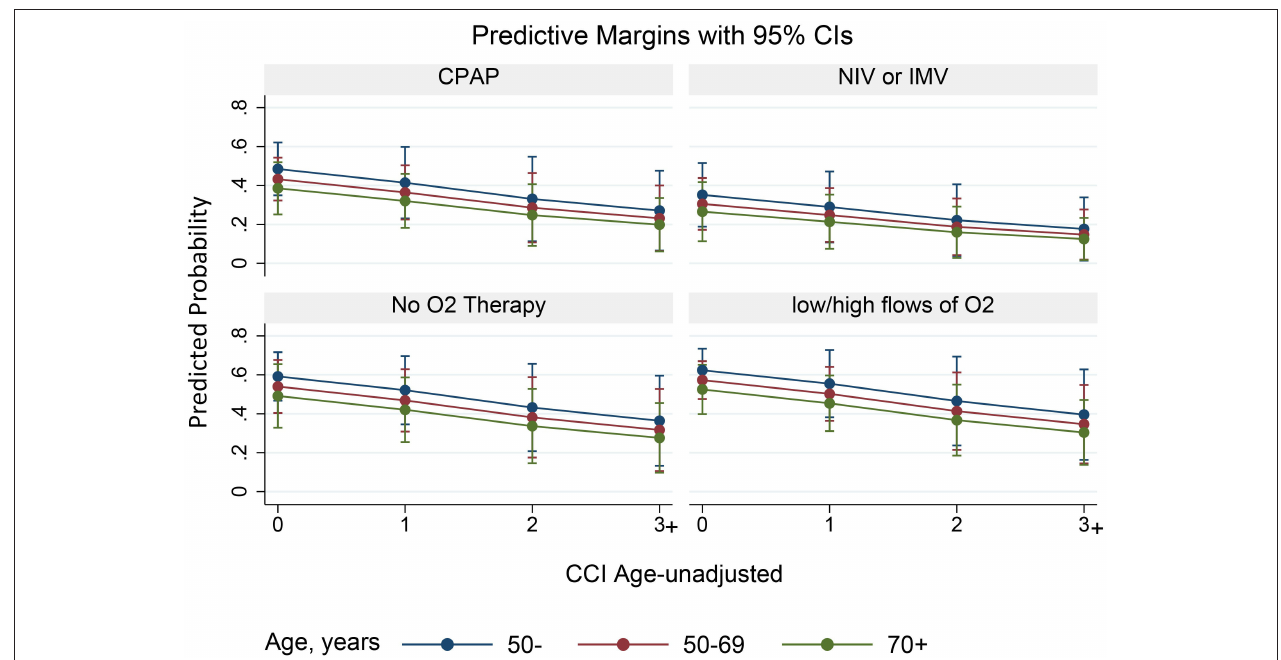
FIGURE 2 | Plots of the marginal predictions of shortening the time spent in isolation by more than 20 days. Predictive margins with 95% CI by subgroups (age classes, CCI, and O 2 therapy) are represented.